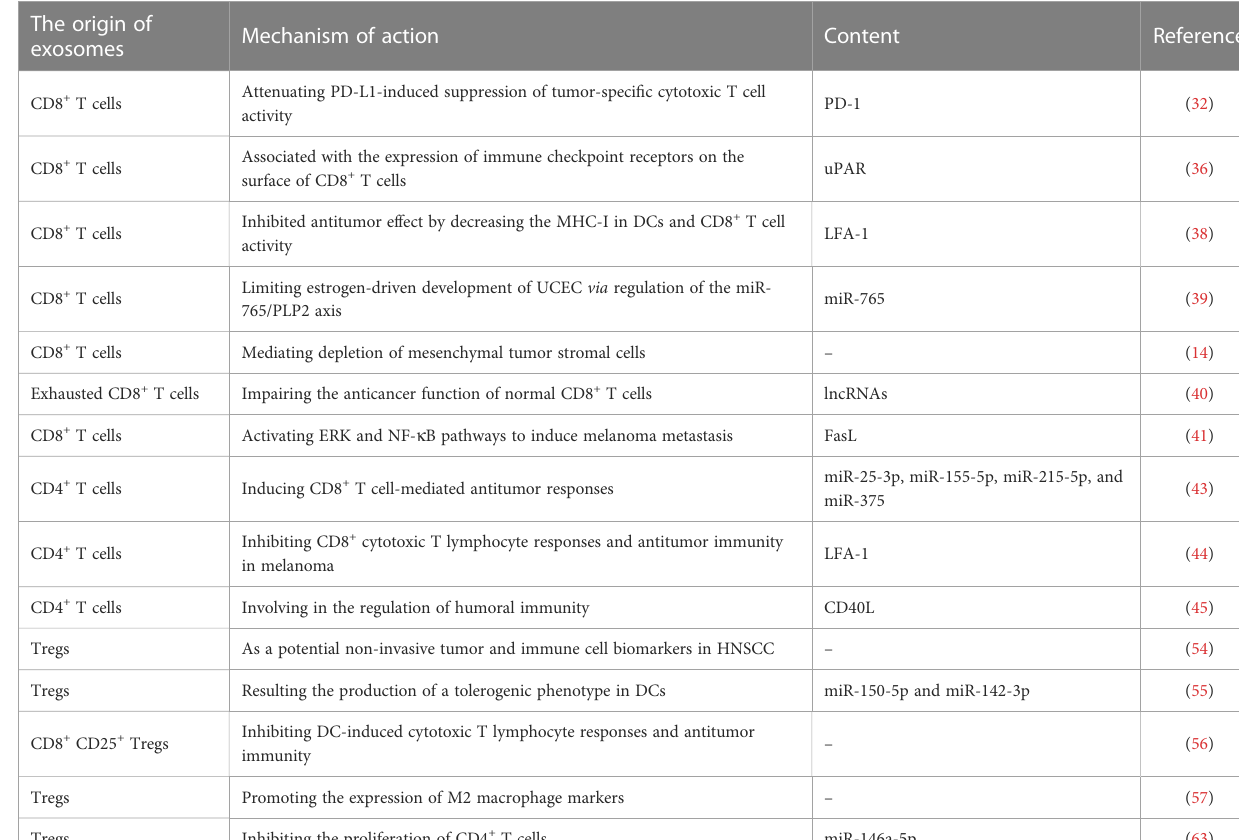
TABLE 1 Role of T cell-derived exosomes in immune